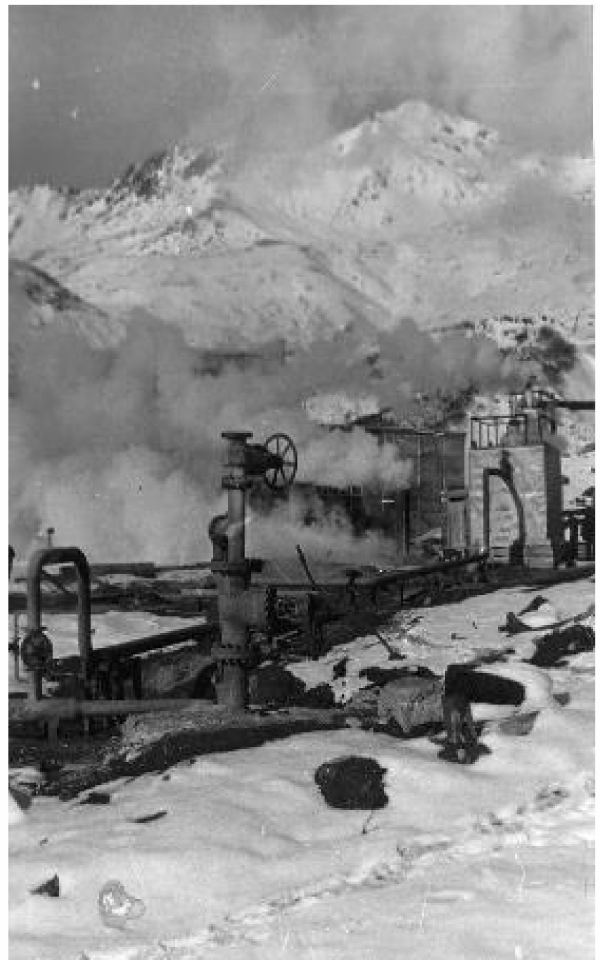
Figure 17. Mutnovskoe deposit of geothermal steam.